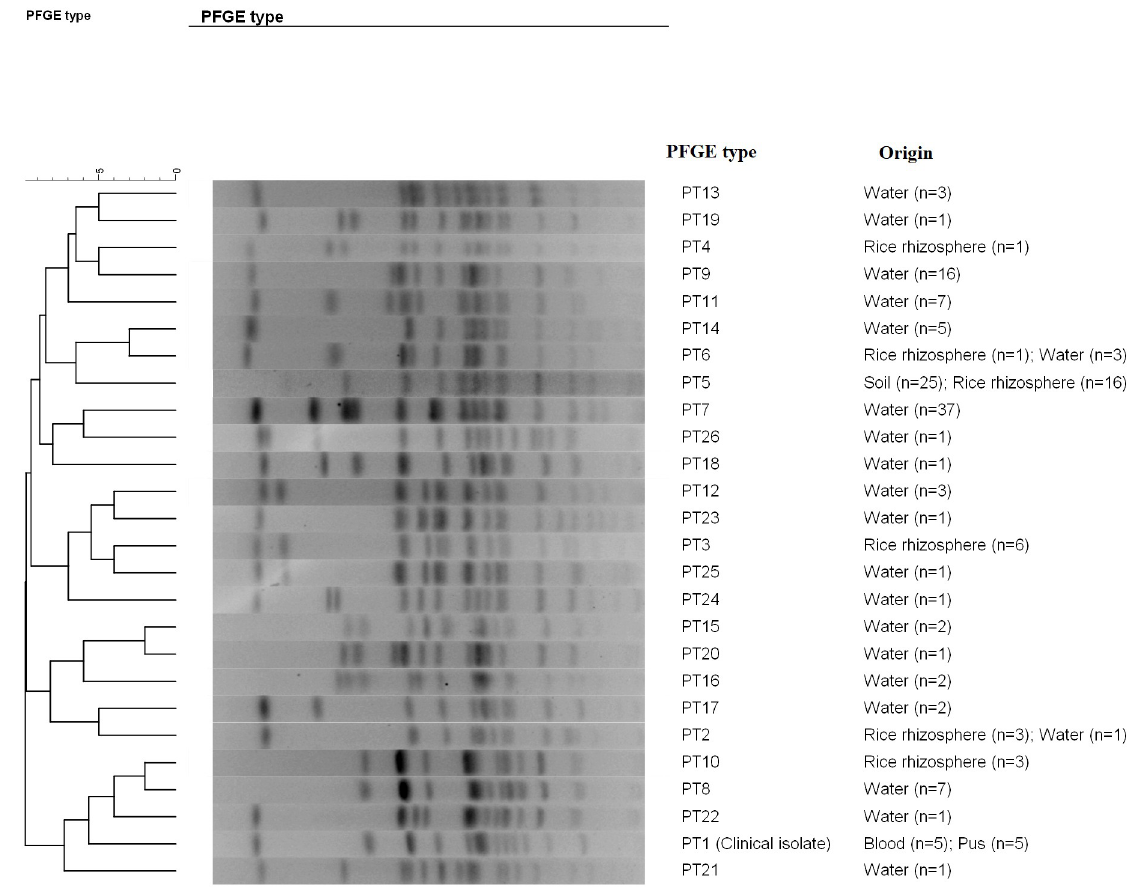
Fig 5. Dendrogram of the 26 representative PFGE types of B . pseudomallei isolated from the patient (PT1), soil, rice rhizosphere and water (PT2 to PT26) collected from the environment near patient’s residence (PT7, PT8 and PT9) and to which the patient was suspected to be exposed (PT2, PT3, PT4, PT5, PT6, PT7, PT8 and PT10 to PT26) in Buriram, Northeast Thailand. A dendrogram was created using the BioNumerics software (version 7.6).